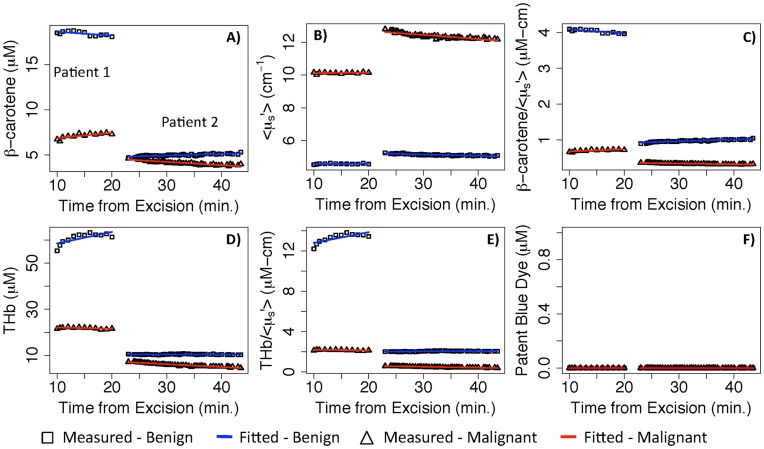
Example plots of kinetics in benign and malignant tissue.Example plots of the tissue parameters versus time for four histologically known sites from two mastectomy patients. Symbols indicate the measured data lines are the model fits for the benign and malignant tissues.